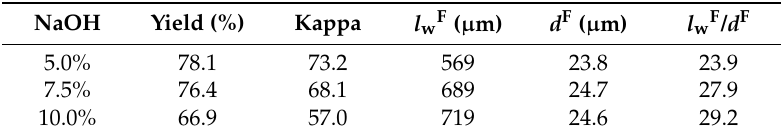
Table 1. Hemp core by-product NaOH-treated fiber experimental